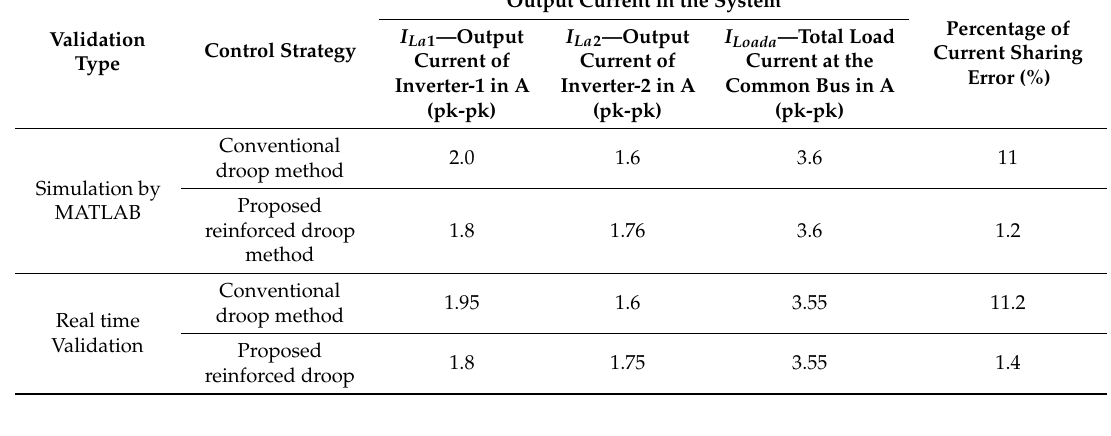
Table 3. Analysis of the conventional and proposed droop method for current sharing during parallel operation.